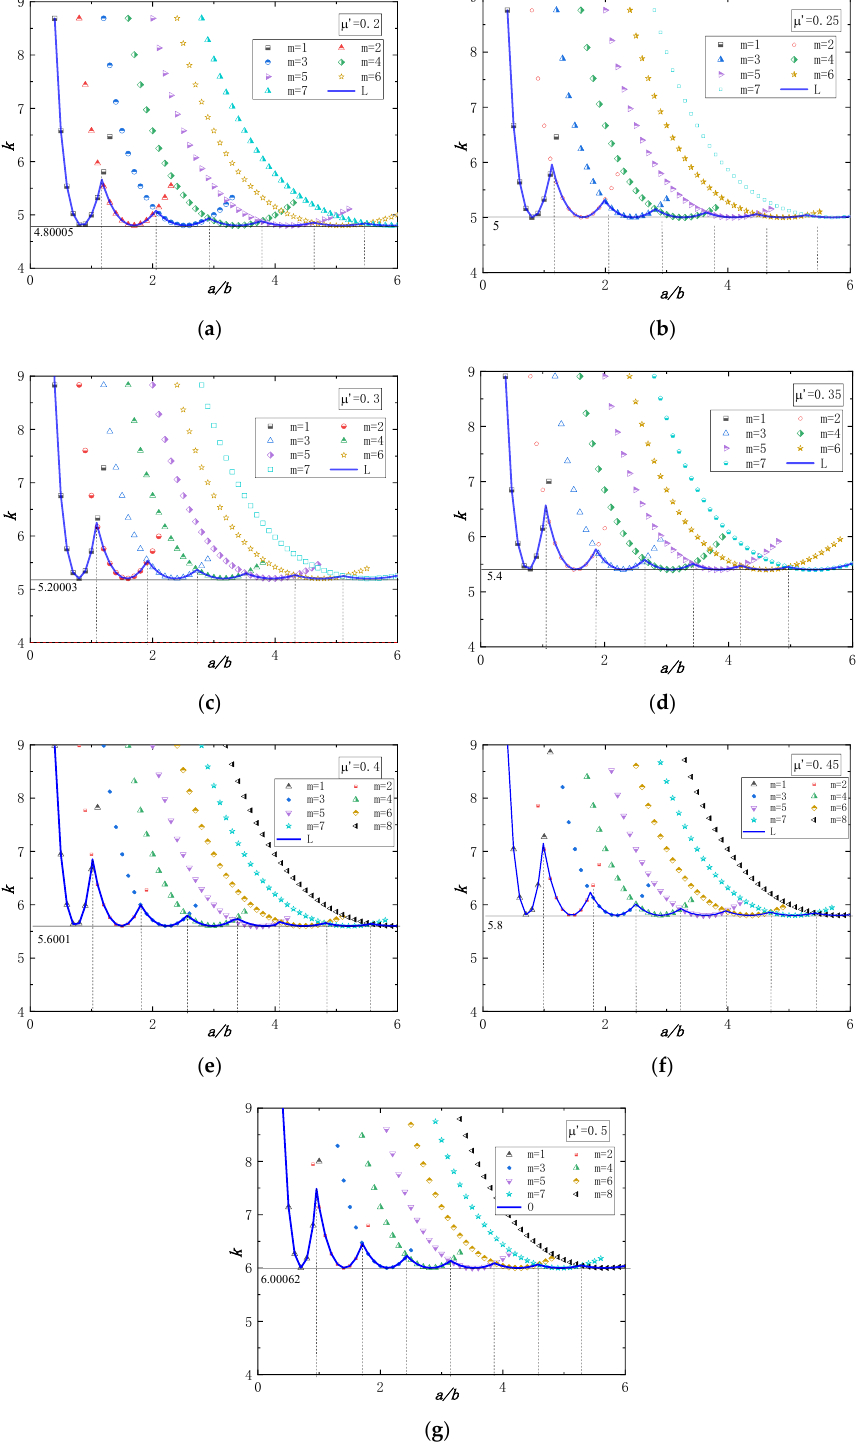
Figure 3. ( a – g ) The variation of the buckling coefficient of the side plate with different height width ratios, half-wave numbers, and nominal Poisson’s ratios (bidirectional